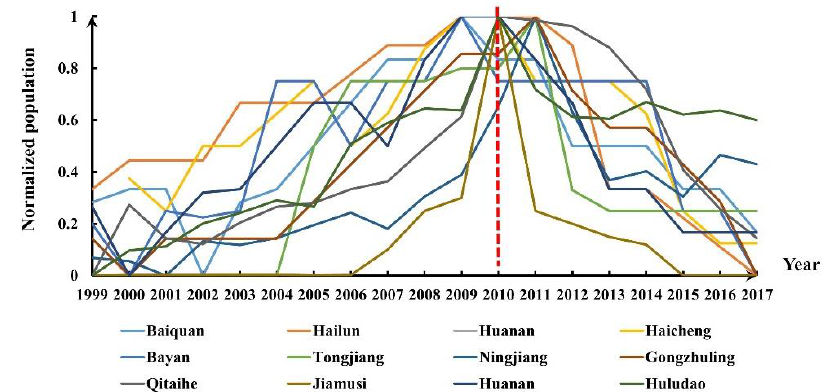
Figure 4. Population curves of some of the cities in NEC.